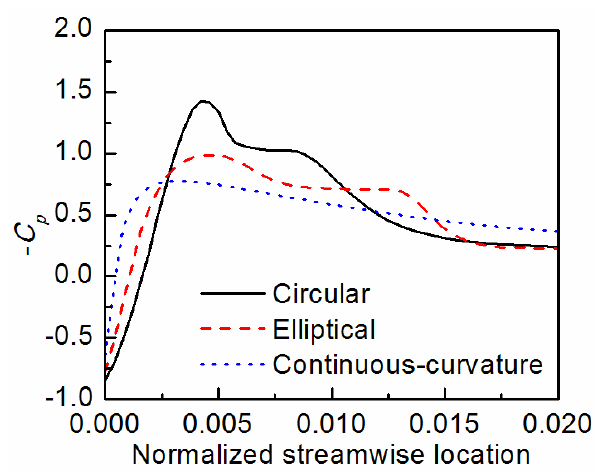
Figure 13. Pressure distributions at α =